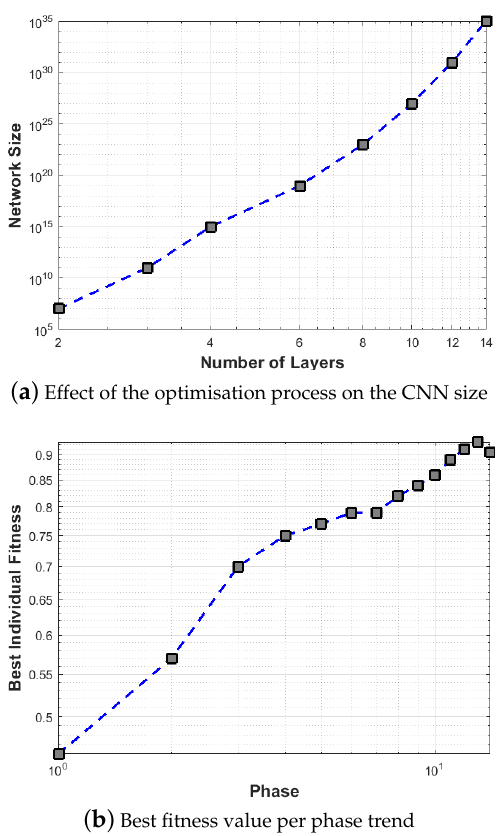
Figure 7. The resulting expansion process. In ( a ) the size of the CNN increases as the number of its layers grows during the 15 performed phases. In ( b ) we show the optimisation process. The decreasing trend at the last 15th phase graphically indicates that the termination criterion (Section 3.4) is